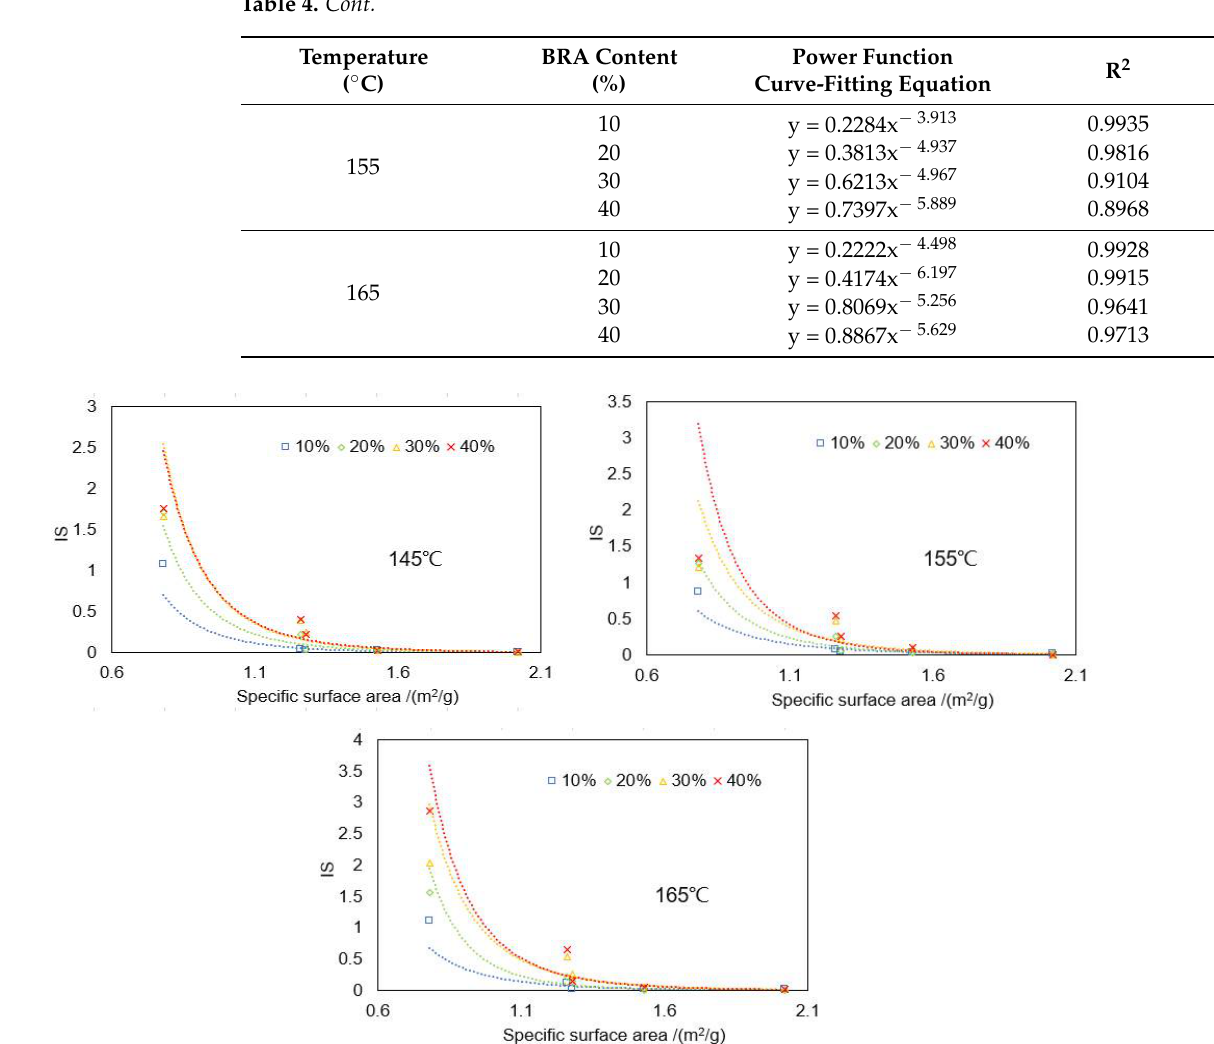
Figure 20. IS of BRA-MA after the segregation process for 24 h static storage at 145 °C, 155 °C, and 165 °C. 165 ◦